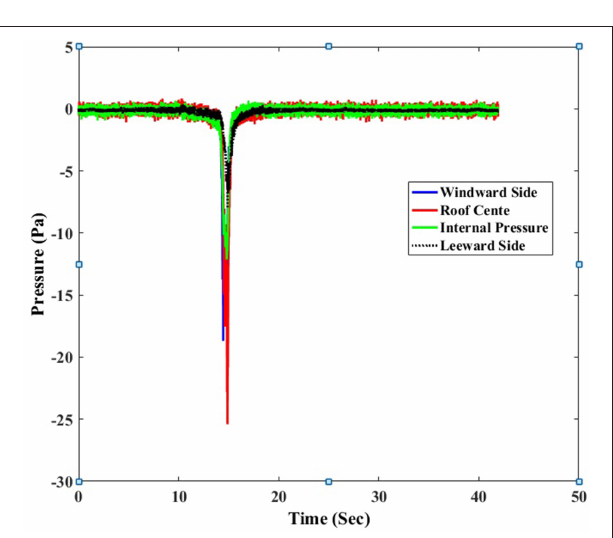
FIGURE 6 | Time history of pressures for pressure taps located on building model at different locations with respect to a translating speed of 180